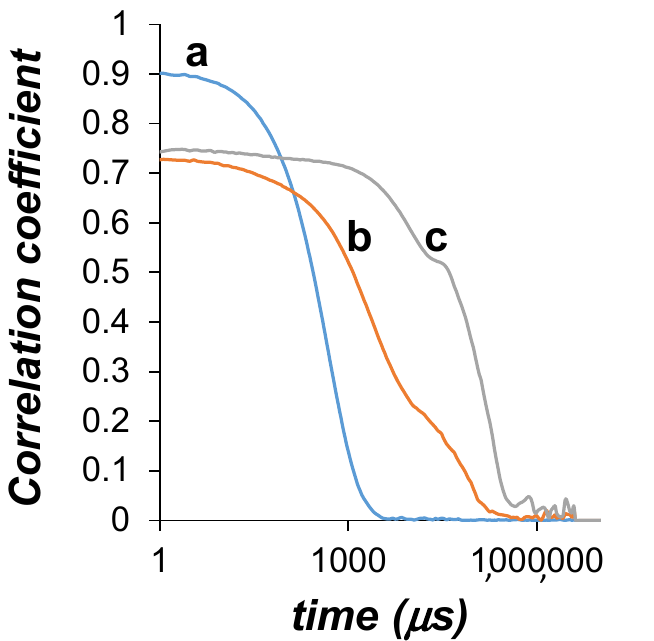
Figure 4. Correlograms obtained by DLS of samples PSS 35 /CPM 18 (a), PSS 40 /CPM 20 (b), and PSS 50 /CPM 25 (c).